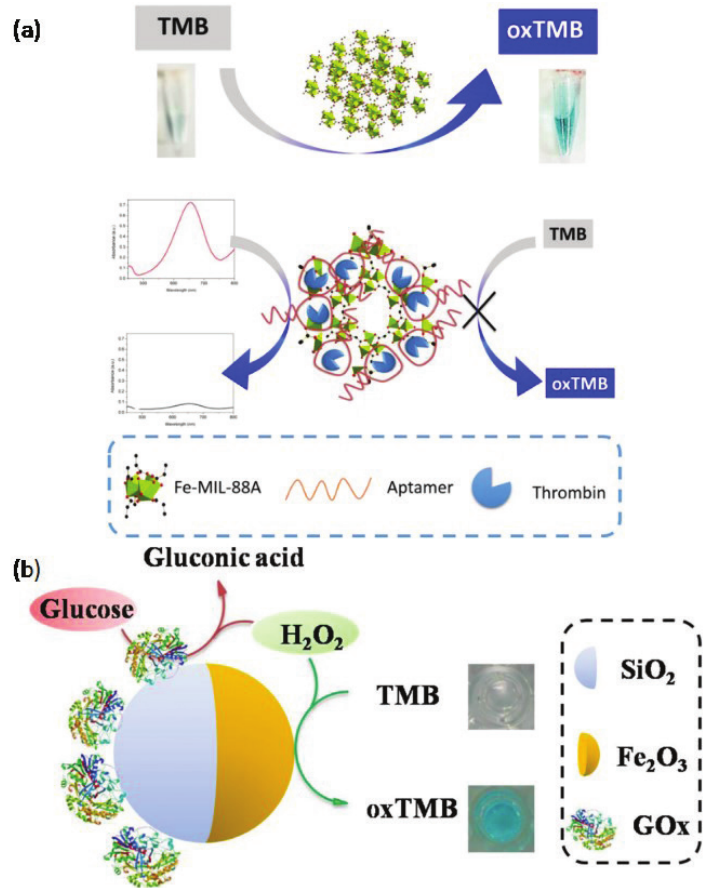
Figure 3: (a) Schematic diagram of Fe-MIL-88A‘s sensing mechanism for thrombin colorimetric detection. Reprinted image with permission from Ref. [70], Copyright 2016, Elsevier B.V. (b) Schematic diagram of biosensor using GOx-JFSNs to detect H image with permission from Ref. [71], Copyright 2015, American Chemical